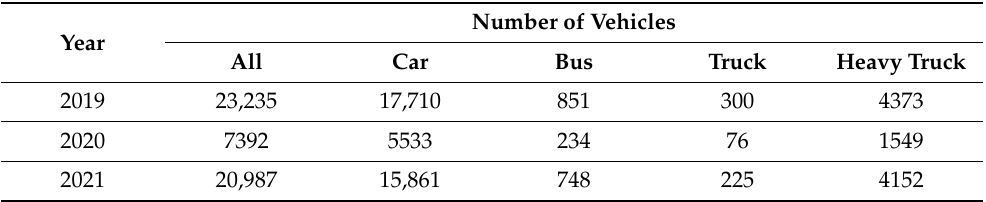
Table 1. Number of vehicles in the simulation. [authors].